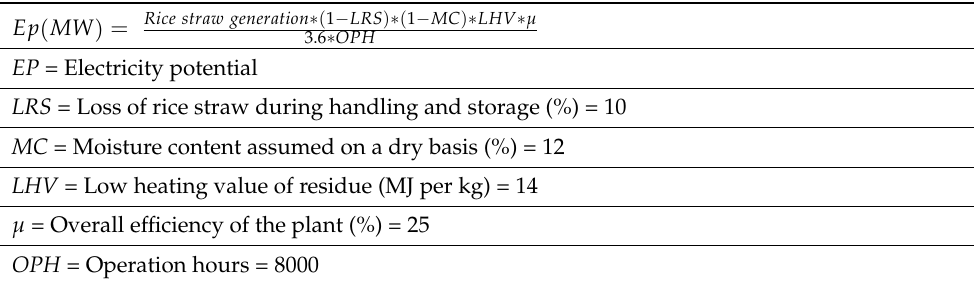
Table 1. Electricity Potential Calculation Method